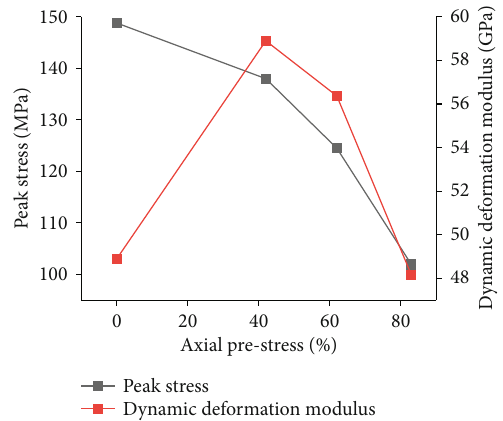
Figure 17: Relationship between the dynamic deformation modulus, peak stress, and axial